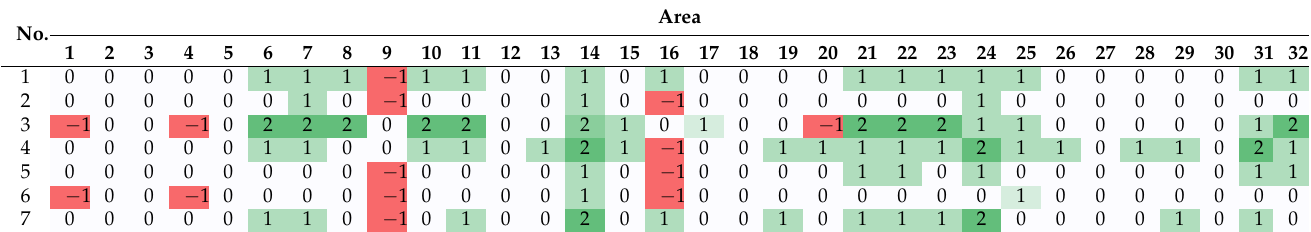
Table 5. Heat map of the medians from the answers given in the survey.